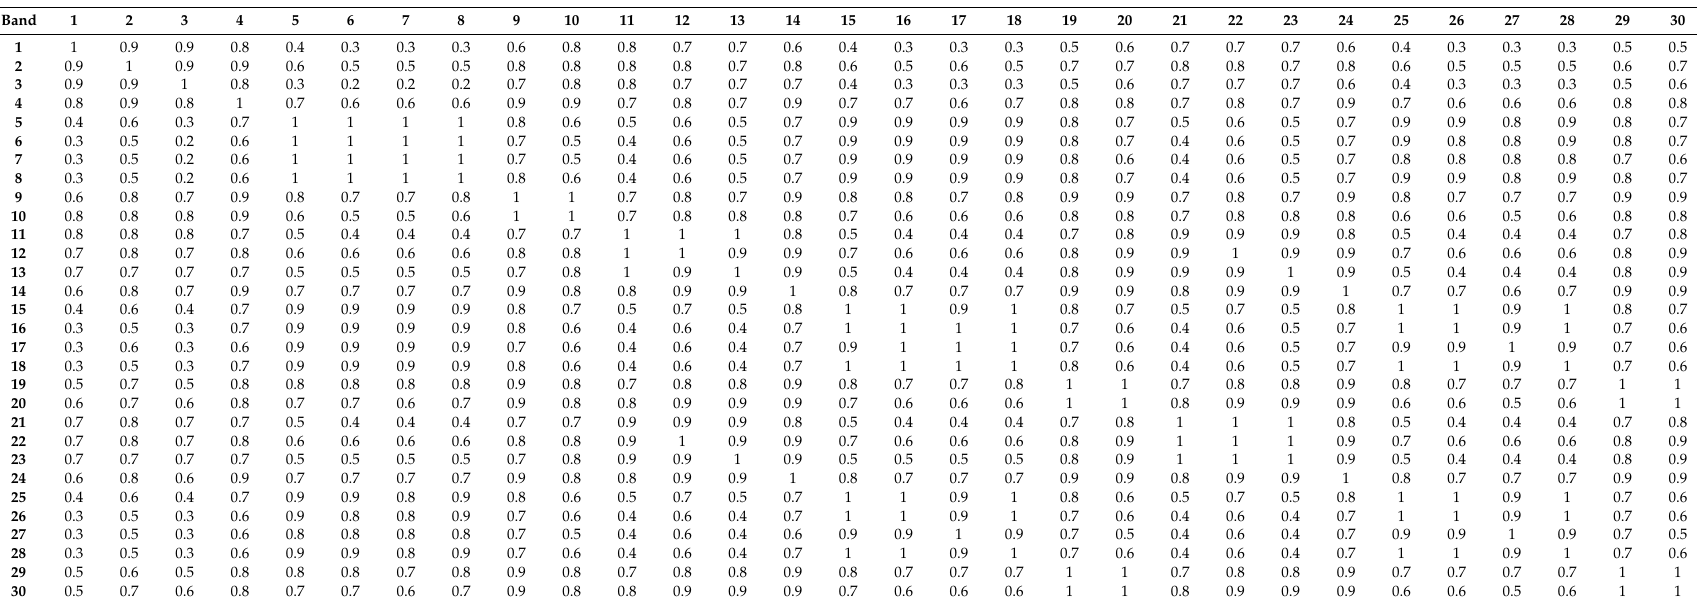
Table A2. Correlation table of variables used to PCA transformation bands